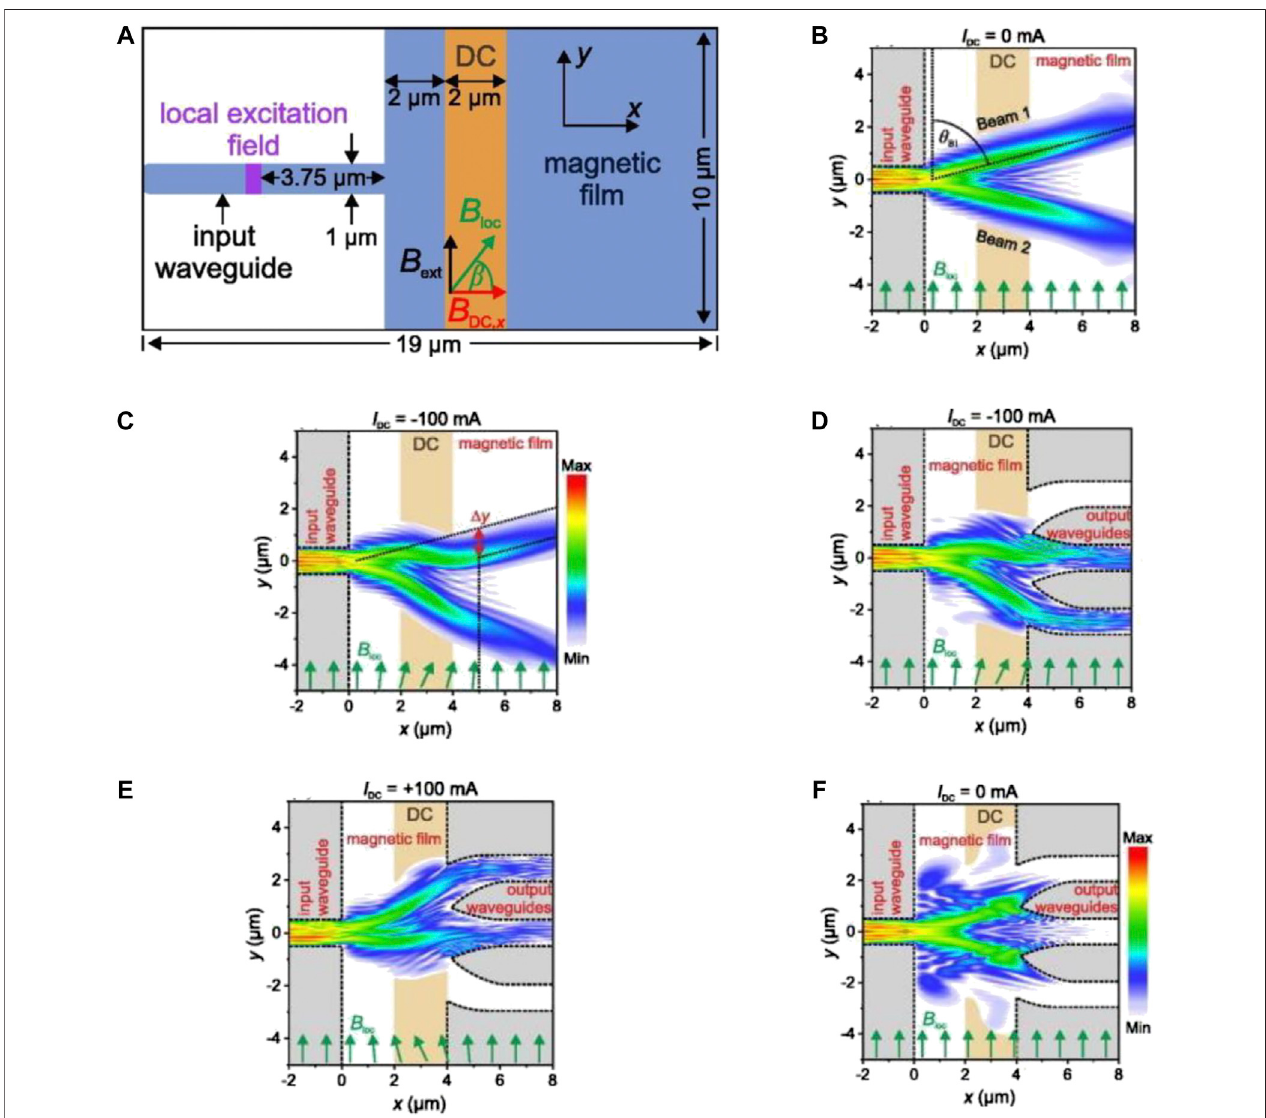
FIGURE8| Spin-wavesignaldividerbasedonchargecurrent. (A) Schematicdiagramofsimulationstructure(Heussneretal.,2017). (B – F) Dynamicmagnetization results. (B) Without applied current; (C) Applying a negative direct current of − 100 mA; (D) Switching between waveguides after applying a negative direct current of − 100 mA; (E) Switching between waveguides after applying a positive direct current of 100 mA; (F) Switching between waveguides without applied current. (A – F) Reprinted from Heussner, F., Serga, A., Brächer, T., Hillebrands, B., and Pirro, P. (2017). A switchable spin-wave signal splitter for magnonic networks. Applied Physics Letters 111 (12), 122401. With the permission of AIP